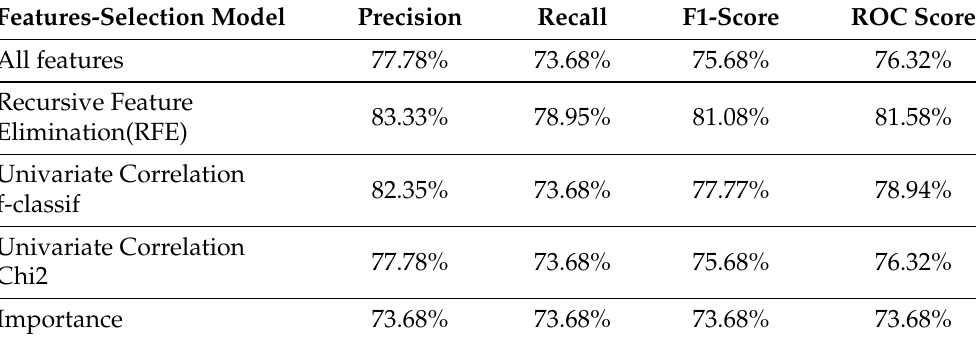
Table A7. Random-Forest classification model prediction results using different features selections